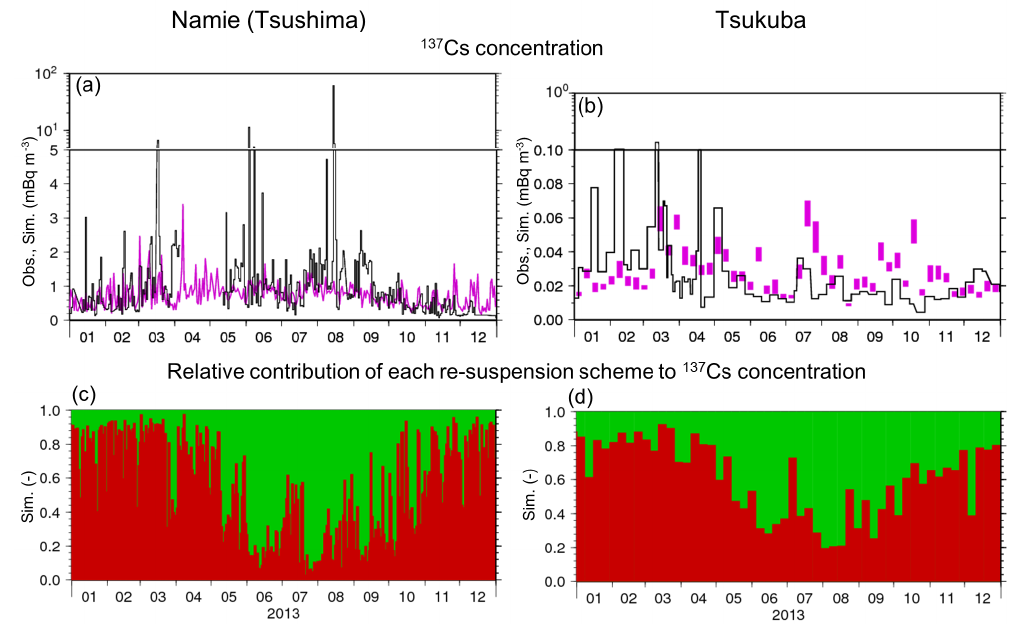
Figure 11. Time series of ( a , b ; black) the observed and (purple) the simulated surface 137 Cs concentration due to total re-suspension and ( c , d ) the relative contribution of (red) dust and (green) forest re-suspension to the 137 Cs concentration at ( a , c ) Namie and ( b , d ) Tsukuba. The shaded areas of (a) and (b) indicate the range of 137 Cs concentrations obtained when the simulations were run using the optimized parameter ranges E c = 0.03–0.05 and v d = 0.05–0.1cms − 1 .